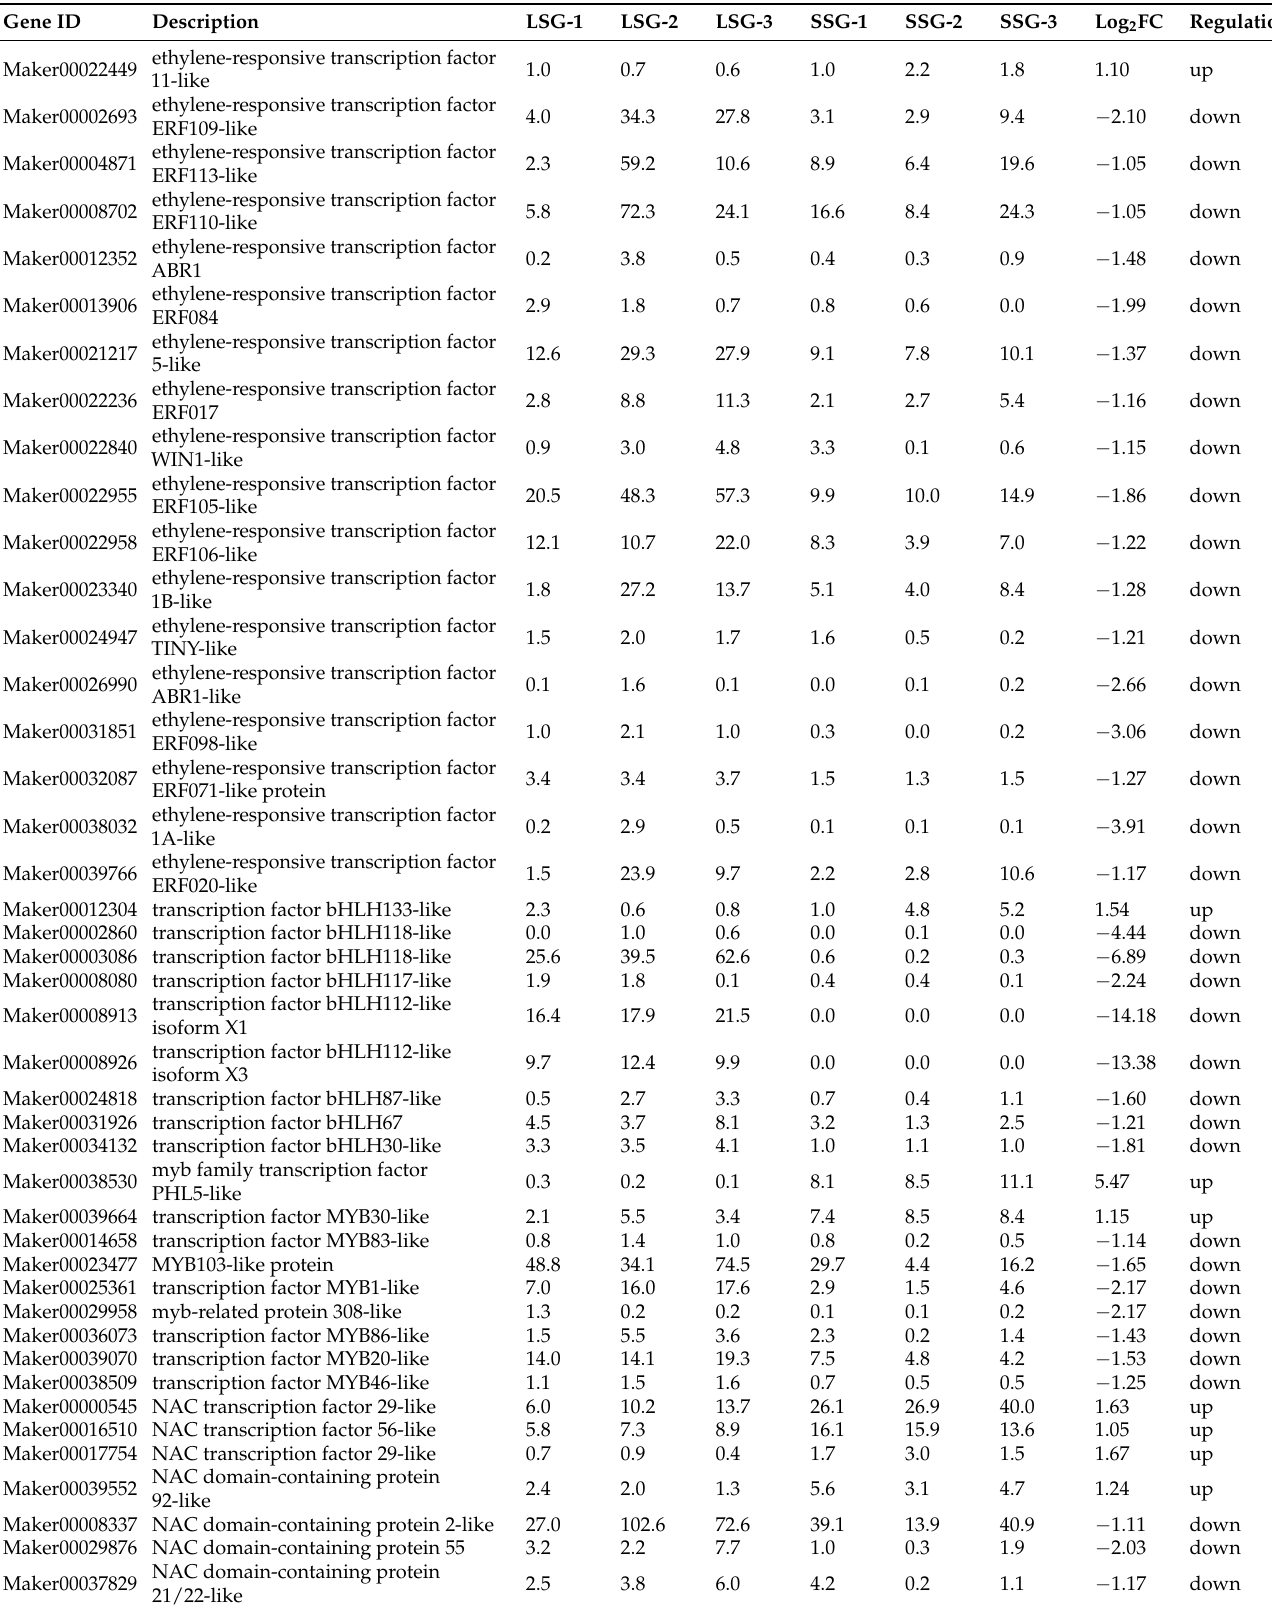
Table 2. DEGs encoding transcription